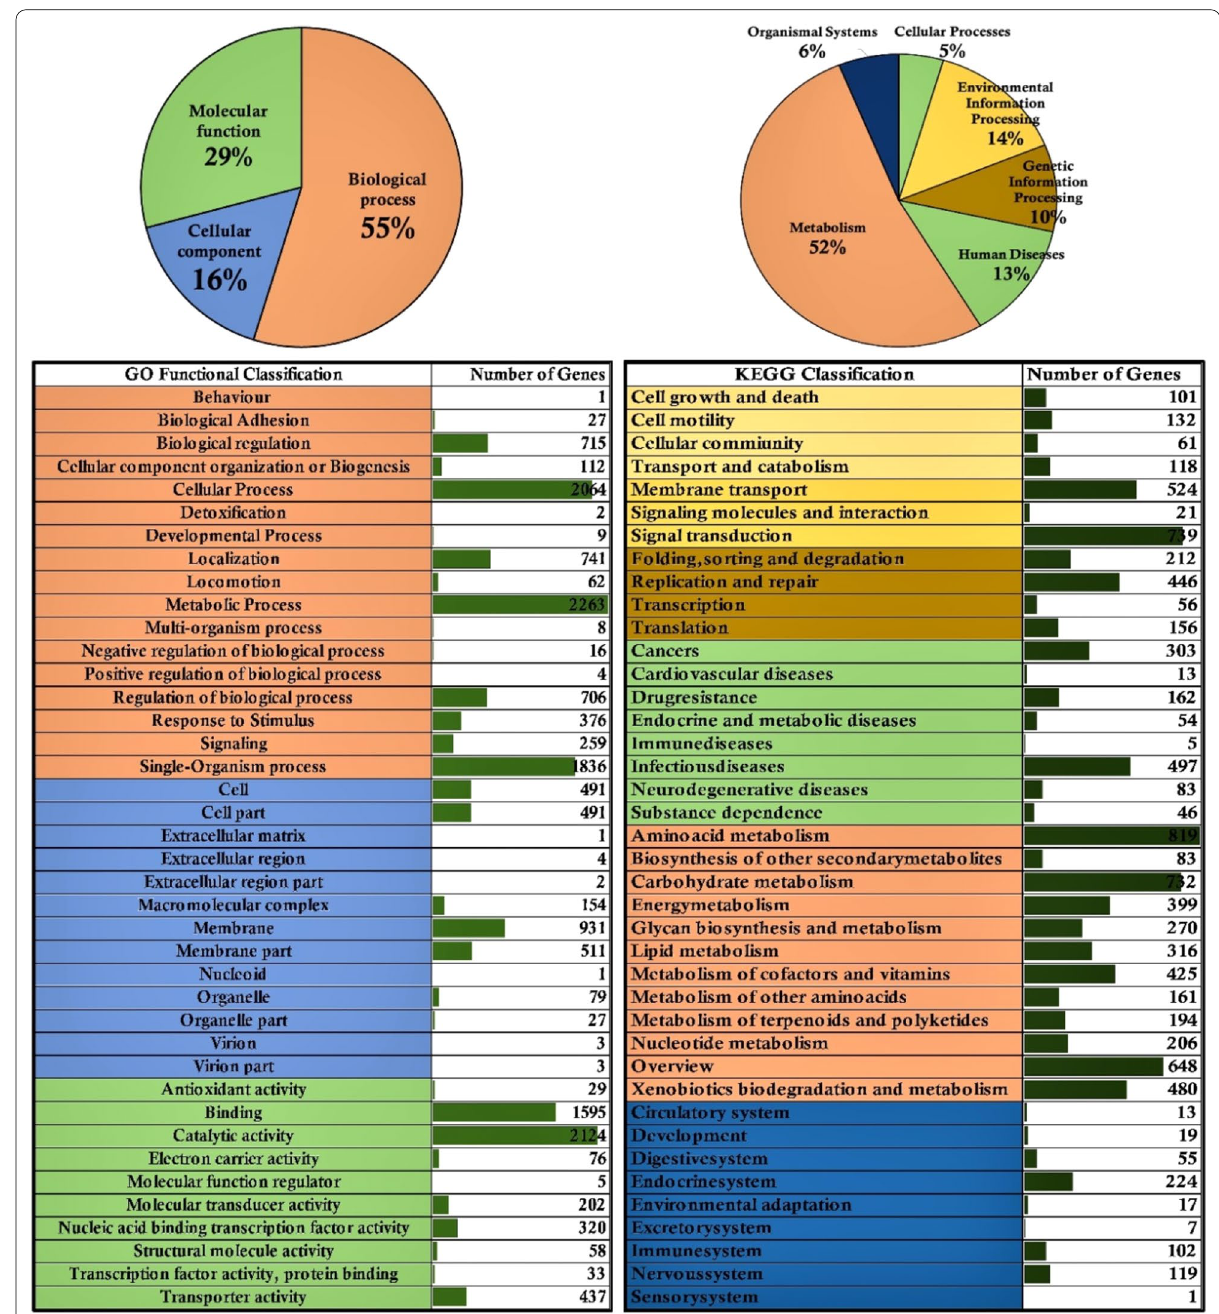
Fig. 3 Pictorial illustration of genome-wide distribution of Pseudomonas sp. NLX-4 strain genes against gene ontology (GO) and KEGG database [Note: pie chart illustrates complete distribution of genes and tabular illustration lists the distribution of genes in individual classes. The color schema uses in pie chart is also applied for the tabular